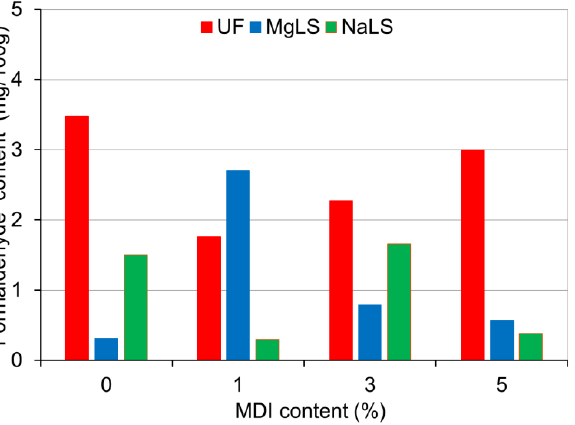
Figure 12. Effect of pMDI content on the MOE of particleboards bonded with pure UF and lignosul- fonate adhesives.